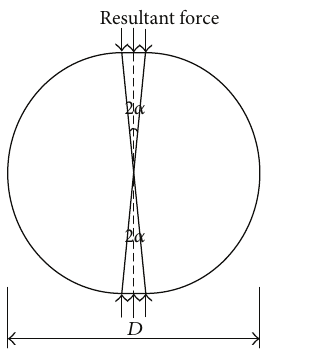
Figure 11: Flattened Brazilian disk specimen subjected to uniform diametral compression [26].